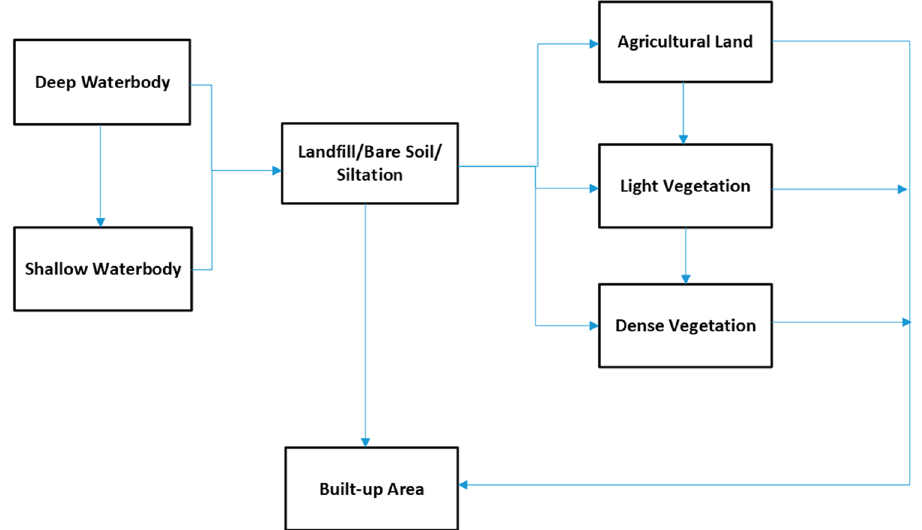
Fig. 10 Land use conversion flow diagram in